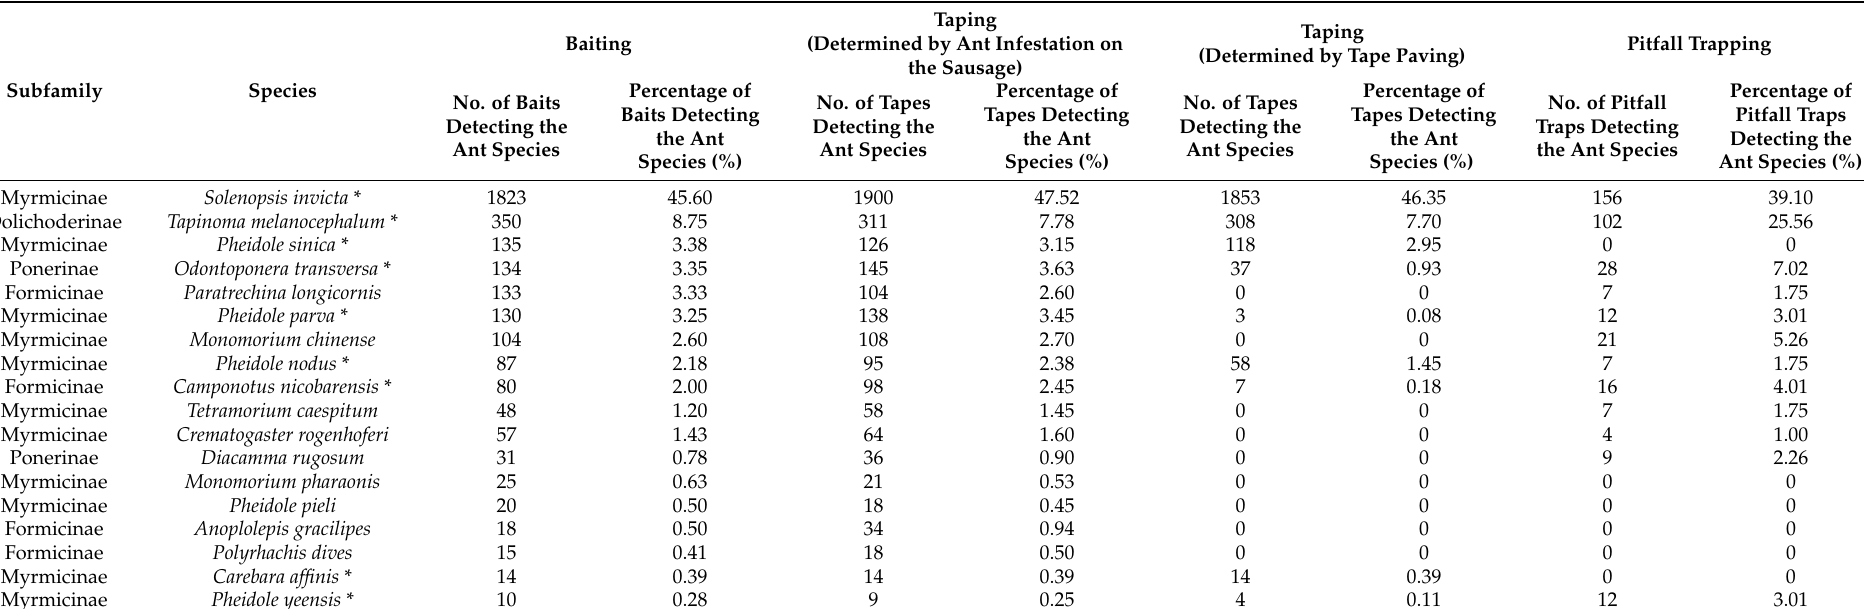
Table 4. Species and percentage of each ant species detected by baits, adhesive tapes (either determined by ant infestation on the sausage or tape paving), or pitfall traps. In total, 3998, 3998, and 399 of baits, adhesive tapes, and pitfall traps were tested, respectively. “*” after the species name indicates that an ant species performed tape-paving